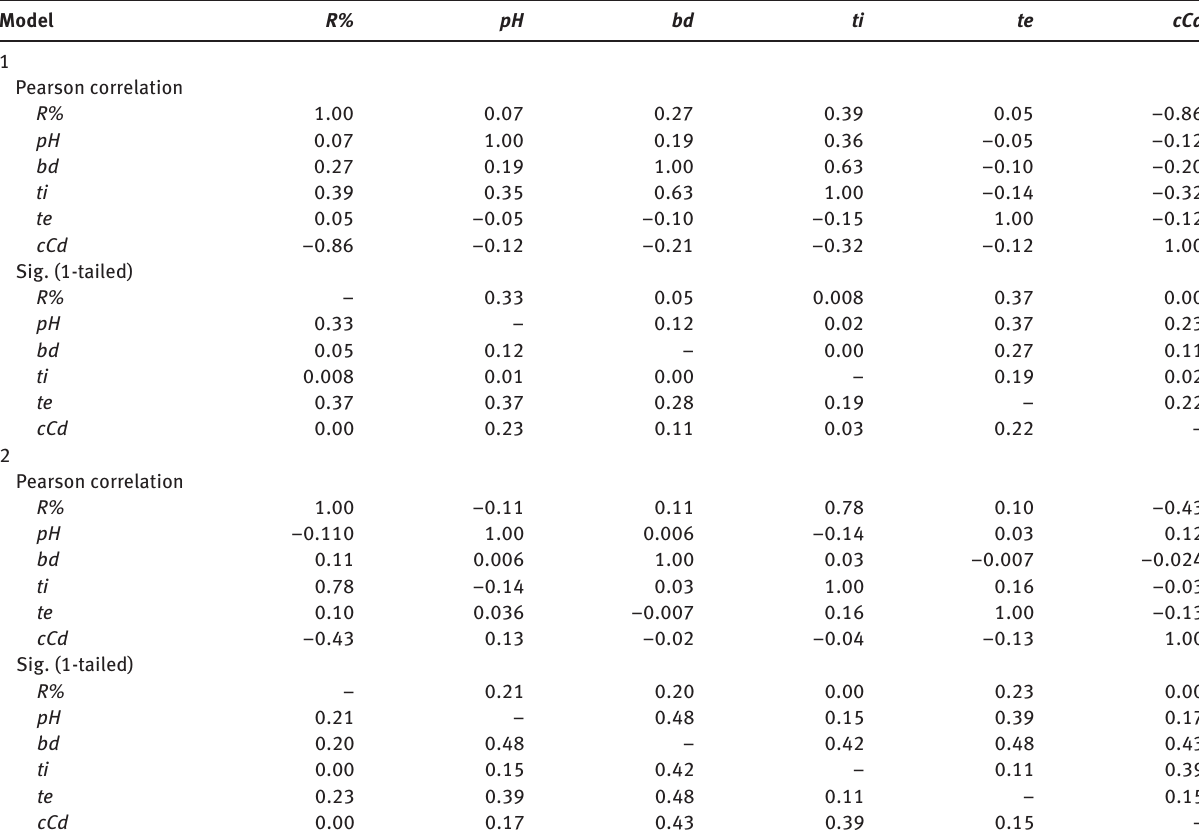
Table 5: Correlation of the determined models. Model